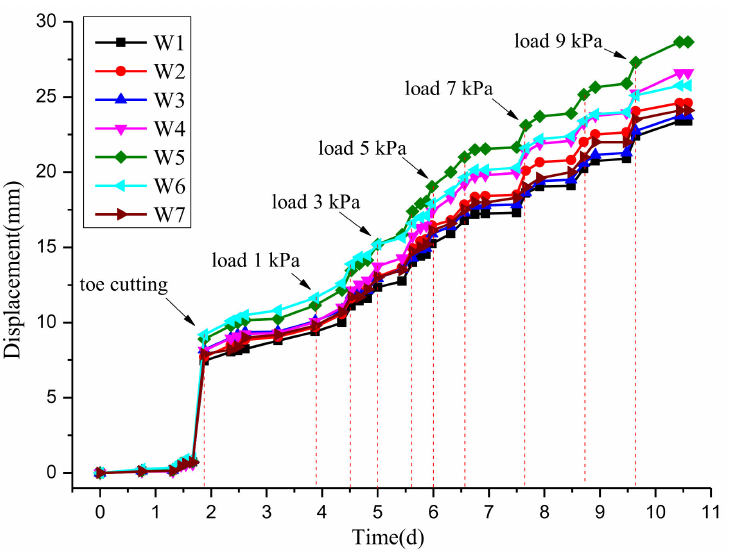
Figure 16. Horizontal displacement curve at the top of the